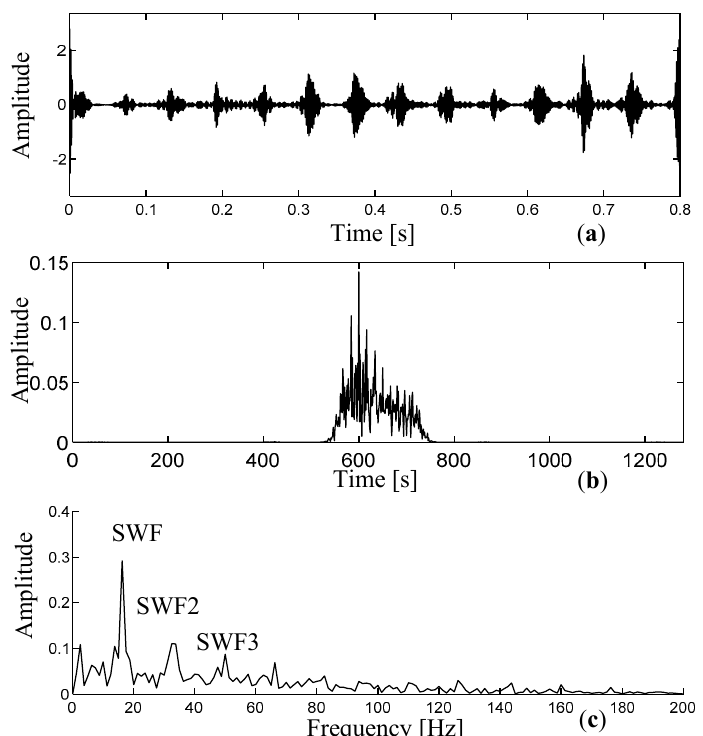
Figure 34. Analysis results of iwp 4,4 ( n ) : ( a ) time domain waveform; ( b ) Fourier spectrum; and ( c ) Hilbert envelope spectrum.